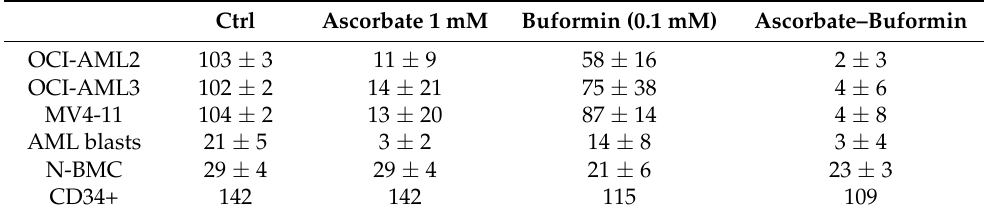
Table 8. Clonogenic Assay. Colony numbers.